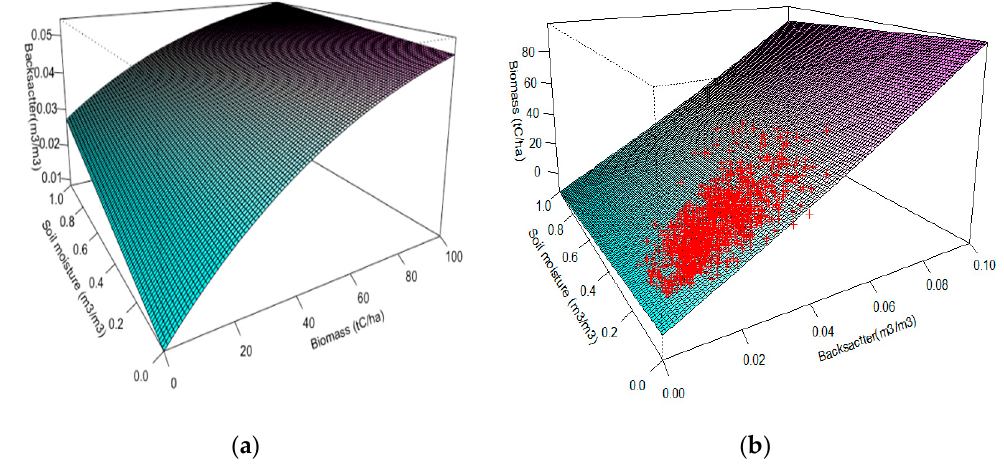
Figure A2. Prediction surface from the fitted WCM std ( a ) and BM-WCM std ( b ) with the calibration data plotted in red points.